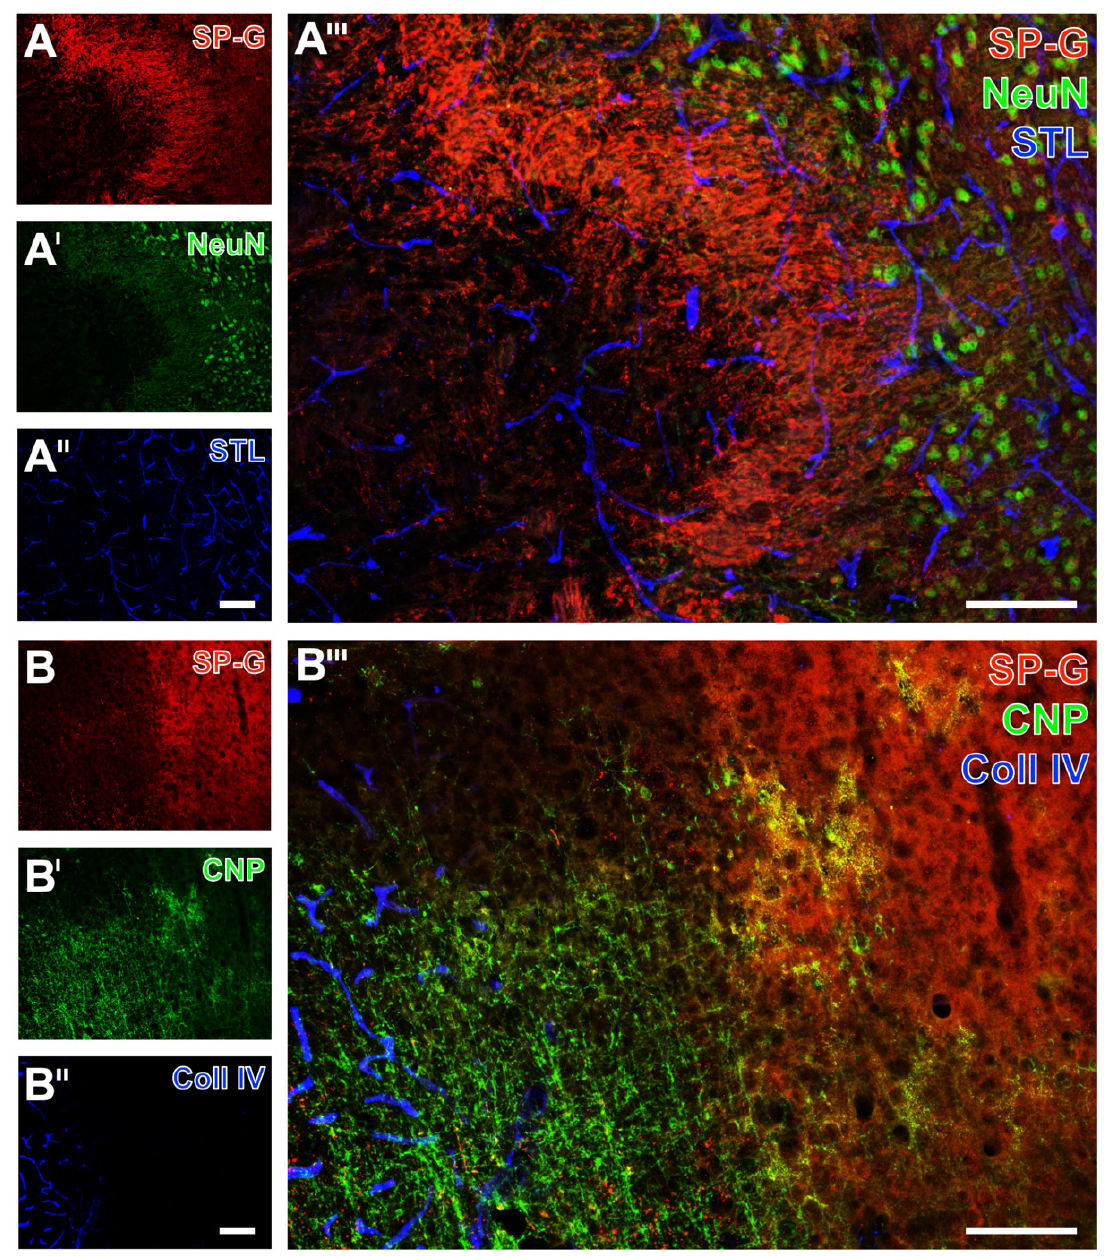
Figure 6. Spatial relationships between surfactant protein-G (SP-G), vascular elements, neurons, and oligodendrocytes after focal cerebral ischemia in mice. Exemplary triple fluorescence labeling of SP-G, Neuronal Nuclei (NeuN) for neurons, and the vasculature with Solanum tuberosum lectin (STL) in the affected striatum of a mouse subjected to 24 h of focal cerebral ischemia ( A – A’’’ ). Representative triple immunofluorescence labeling of SP-G, 2 ′ ,3 ′ -cyclic nucleotide phosphodiesterase (CNP) for oligodendrocytes and collagen (Coll) IV for the vasculature in the affected neocortex of a mouse 72 h after ischemia onset ( B – B’’’ ). Scale bars: A’’ (also valid for A and A’ ) = 100 μ m, A’’’ = 100 μ m, B’’ (also valid for B and B’ ) = 100 μ m, B’’’ = 100 μ m.